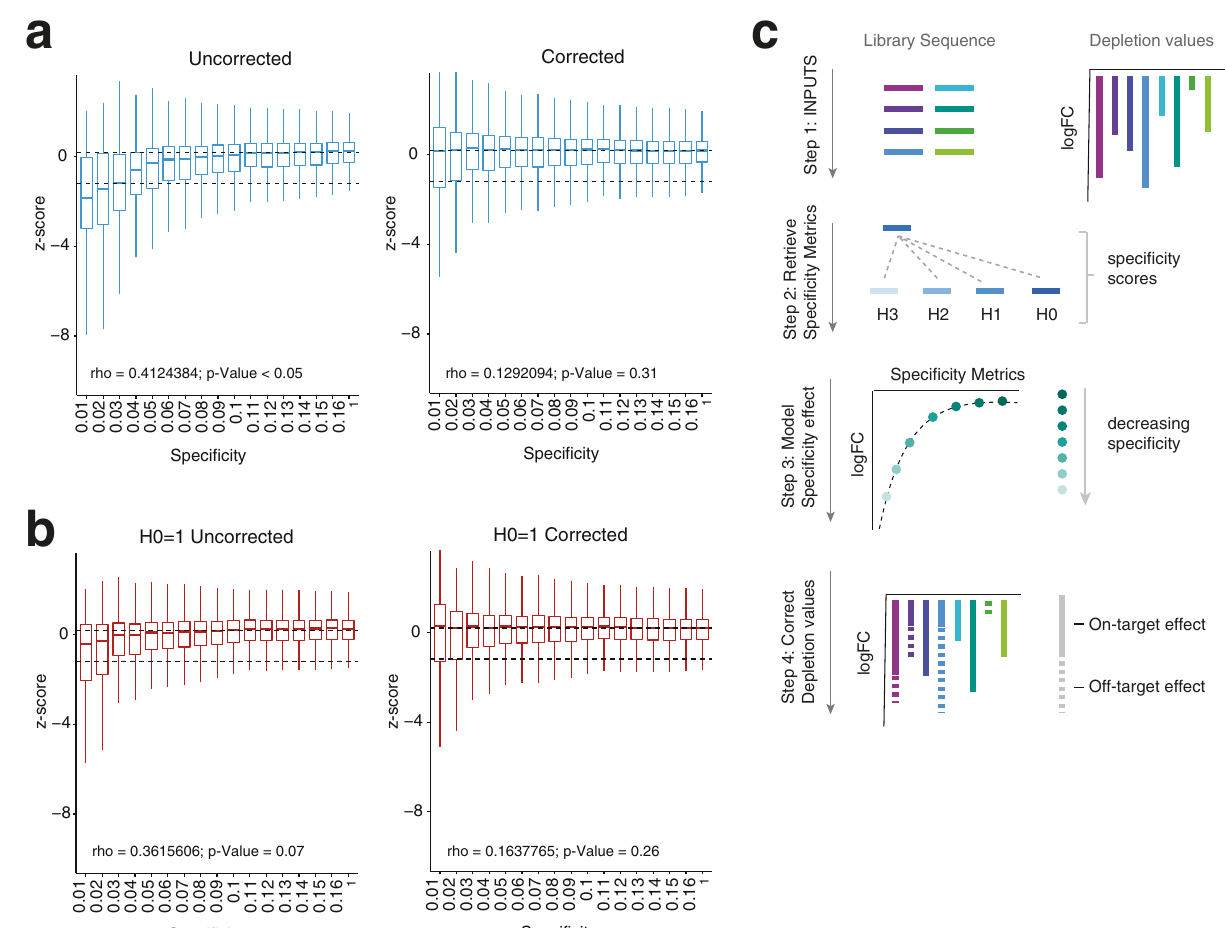
Fig. 2 Computational correction of off-target mediated gRNA depletion from CRISPR-Cas9 essentiality screens. a Boxplots of z -scores for gRNA log2- fold changes for Avana Project Score 19Q4 screens ( n = 689) across multiple speci fi city bins before (left) and after (right) correction. Speci fi city values correspond to highest value of each bin. Dashed lines indicate median depletion of speci fi c gRNAs (GuideScan score = 1) targeting known non-essential (top) or essential (bottom) genes. One-sided Pearson correlation values between speci fi city and mean depletion of gRNAs in each bin are shown, along with their signi fi cance. Boxplots show minimum, maximum, median, fi rst, and third quartiles. b As in a but plotting only gRNAs that have a single perfect target site in the genome (H0 = 1; H0, hamming distance of 0). One-sided Pearson correlation values between speci fi city and mean depletion of gRNAs in each bin are shown, along with their signi fi cance. Boxplots show minimum, maximum, median, fi rst, and third quartiles. c Schematic representation of CSC. Brie fl y, the correction takes as input the gRNA sequences and corresponding depletion values. For each of the gRNAs, CSC enumerates all off-targets up to Hamming distance of 3 (H3) and computes its speci fi city score. CSC then uses the off-target information and depletion values to model the effect of off- targeting on gRNA abundance. Finally, it outputs both the corrected depletion values and the speci fi city metrics for each of the gRNAs. logFC, log fold